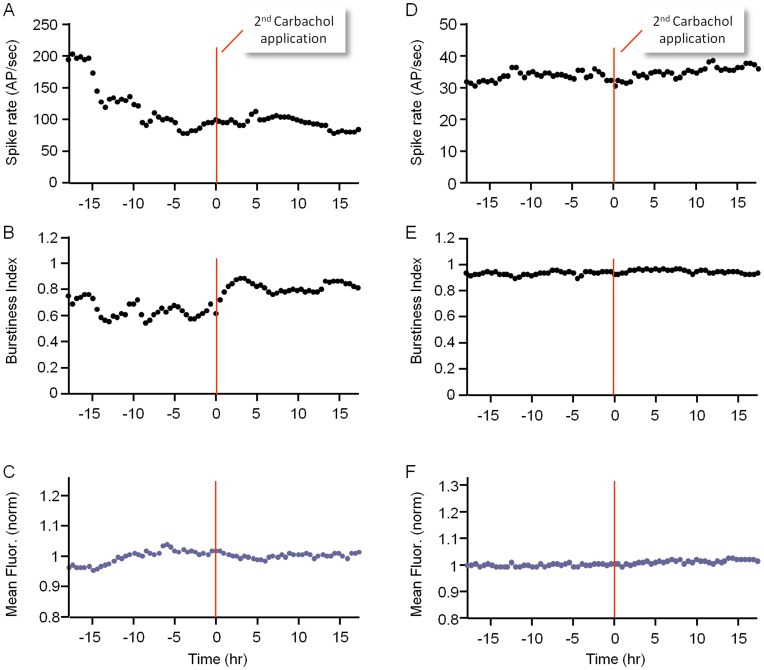
Second applications of freshly prepared CCh solutions do not affect activity characteristics or synaptic growth.Two experiments (out of three in total) in which a second bolus of freshly prepared CCh solution was added to the MEA dishes 143 h (left, same experiment as Figure 1) and 137 hours (right) after the experiment was started (45 and 89 hours after first CCh application, respectively). A) Spontaneous activity rates. B) Burstiness index. C) Mean synaptic size (left - 5 sites; right - 8 sites).